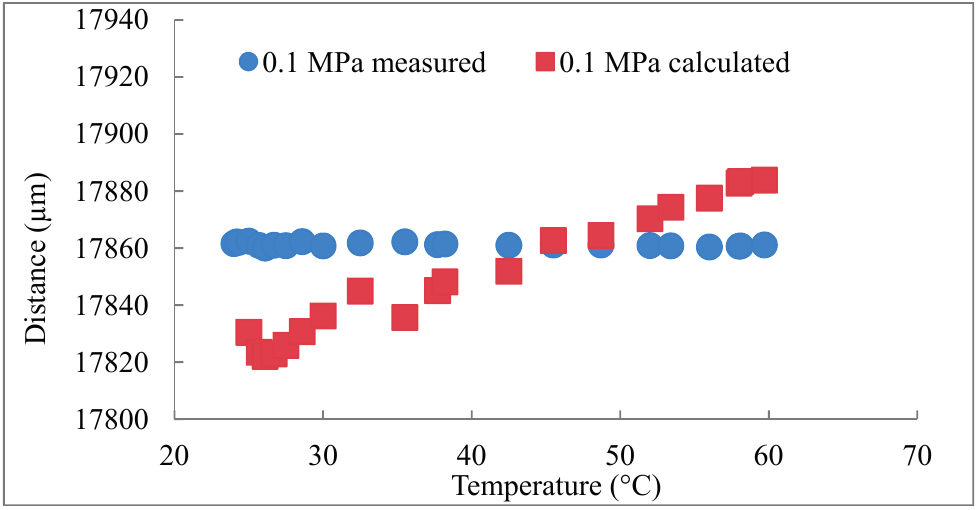
= 0.6 µm, σ = 20.8 µm. measured B&S